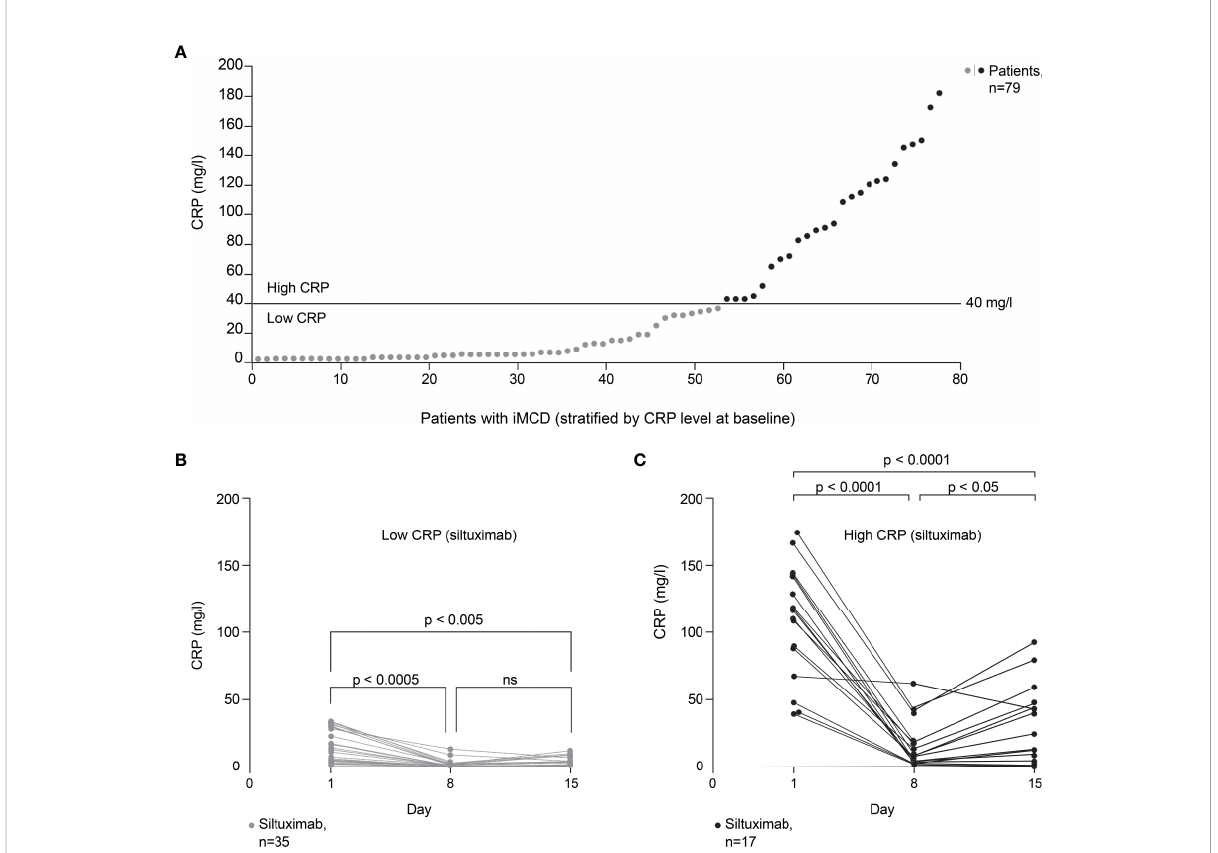
FIGURE 3 Effect of baseline CRP level on response to siltuximab in patients with iMCD. Exploratory post hoc analysis of patients with iMCD from study NCT01024036 (siltuximab, n=53; placebo, n=26) (9). (A) Patients (n=79) classi fi ed as having low or high baseline CRP levels using a threshold of 40 mg/l (corresponding to approximately 40 pg/ml of IL-6). (B) In patients with low baseline CRP levels ( ≤ 40 mg/l) who were treated with siltuximab (n=35), CRP levels were signi fi cantly reduced versus baseline on day 8 (n=26; p = 0.0003) and day 15 (n=22; p = 0.0043). (C) In patients with high baseline CRP levels (>40 mg/l) who were treated with siltuximab (n=17), CRP levels were signi fi cantly reduced versus baseline on day 8 (n=17; p < 0.0001) and day 15 (n=15; p < 0.0001). A signi fi cant increase in CRP levels from day 8 to day 15 was observed in this patient group (p = 0.0120). One-way analysis of variance and Tukey ’ s multiple comparisons tests were used for all analyses. CRP, C-reactive protein; IL-6, interleukin-6; iMCD, idiopathic multicentric Castleman disease; ns, not signi fi